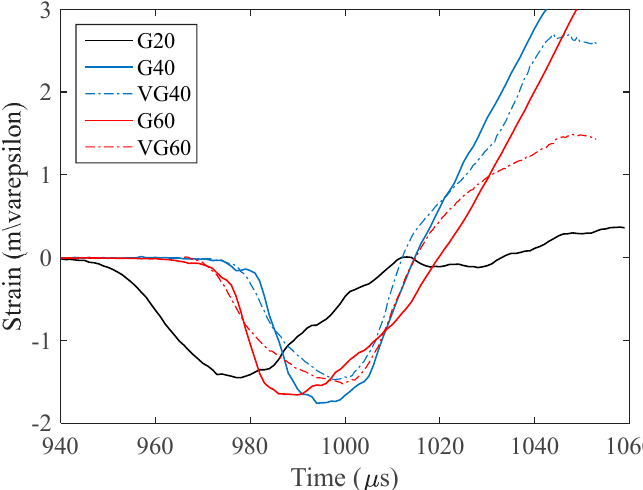
Figure 4. Data of strain-gauges from spalling test n°2.